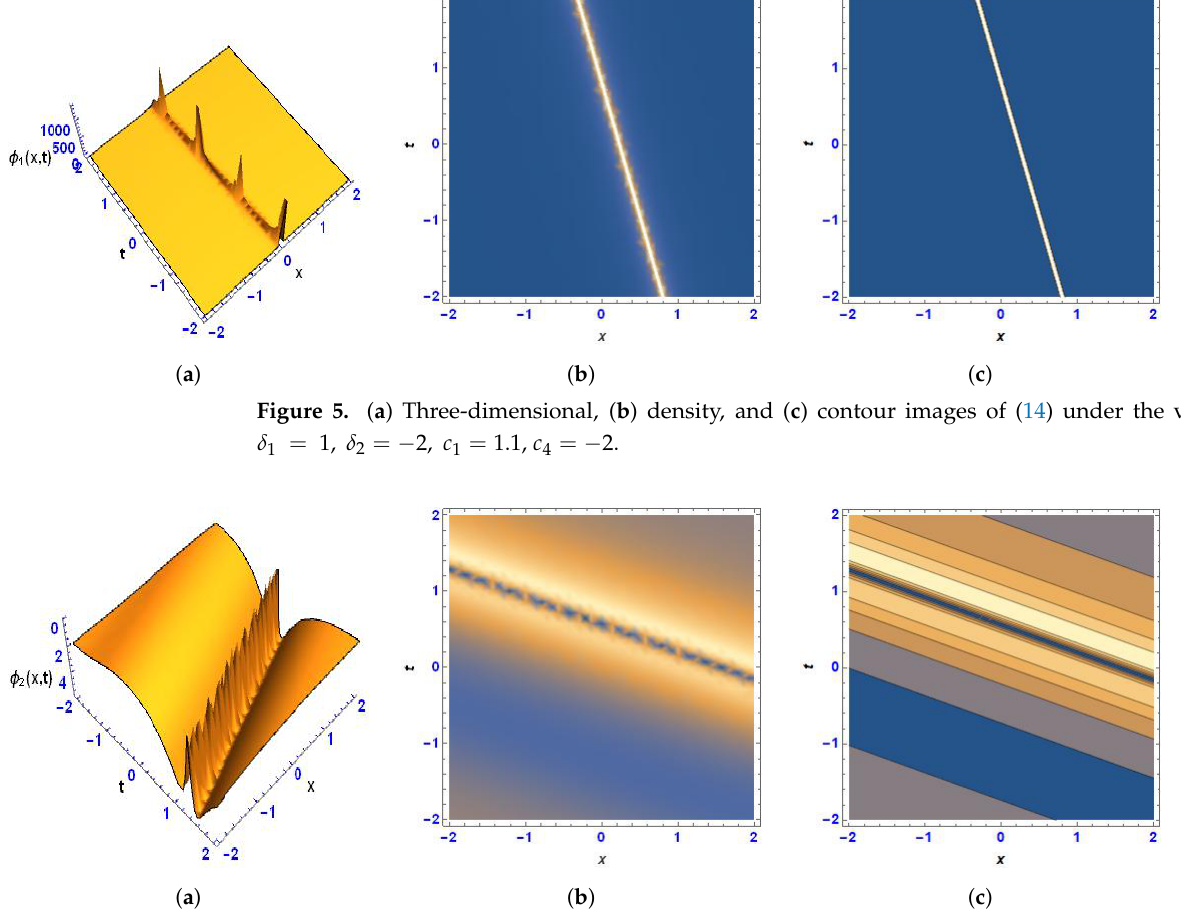
Figure 6. ( a ) Three-dimensional, ( b ) density, and ( c ) contour images of (15) under the values δ 1 = − 0.5, c 2 = 5.65, c 1 = − 1.1, c 3 =